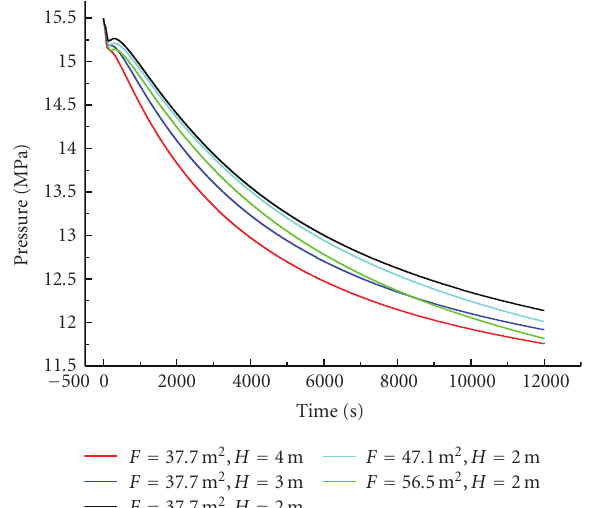
Figure 12: Pressure of pressurizer with di ff erent height di ff erences and heat transfer